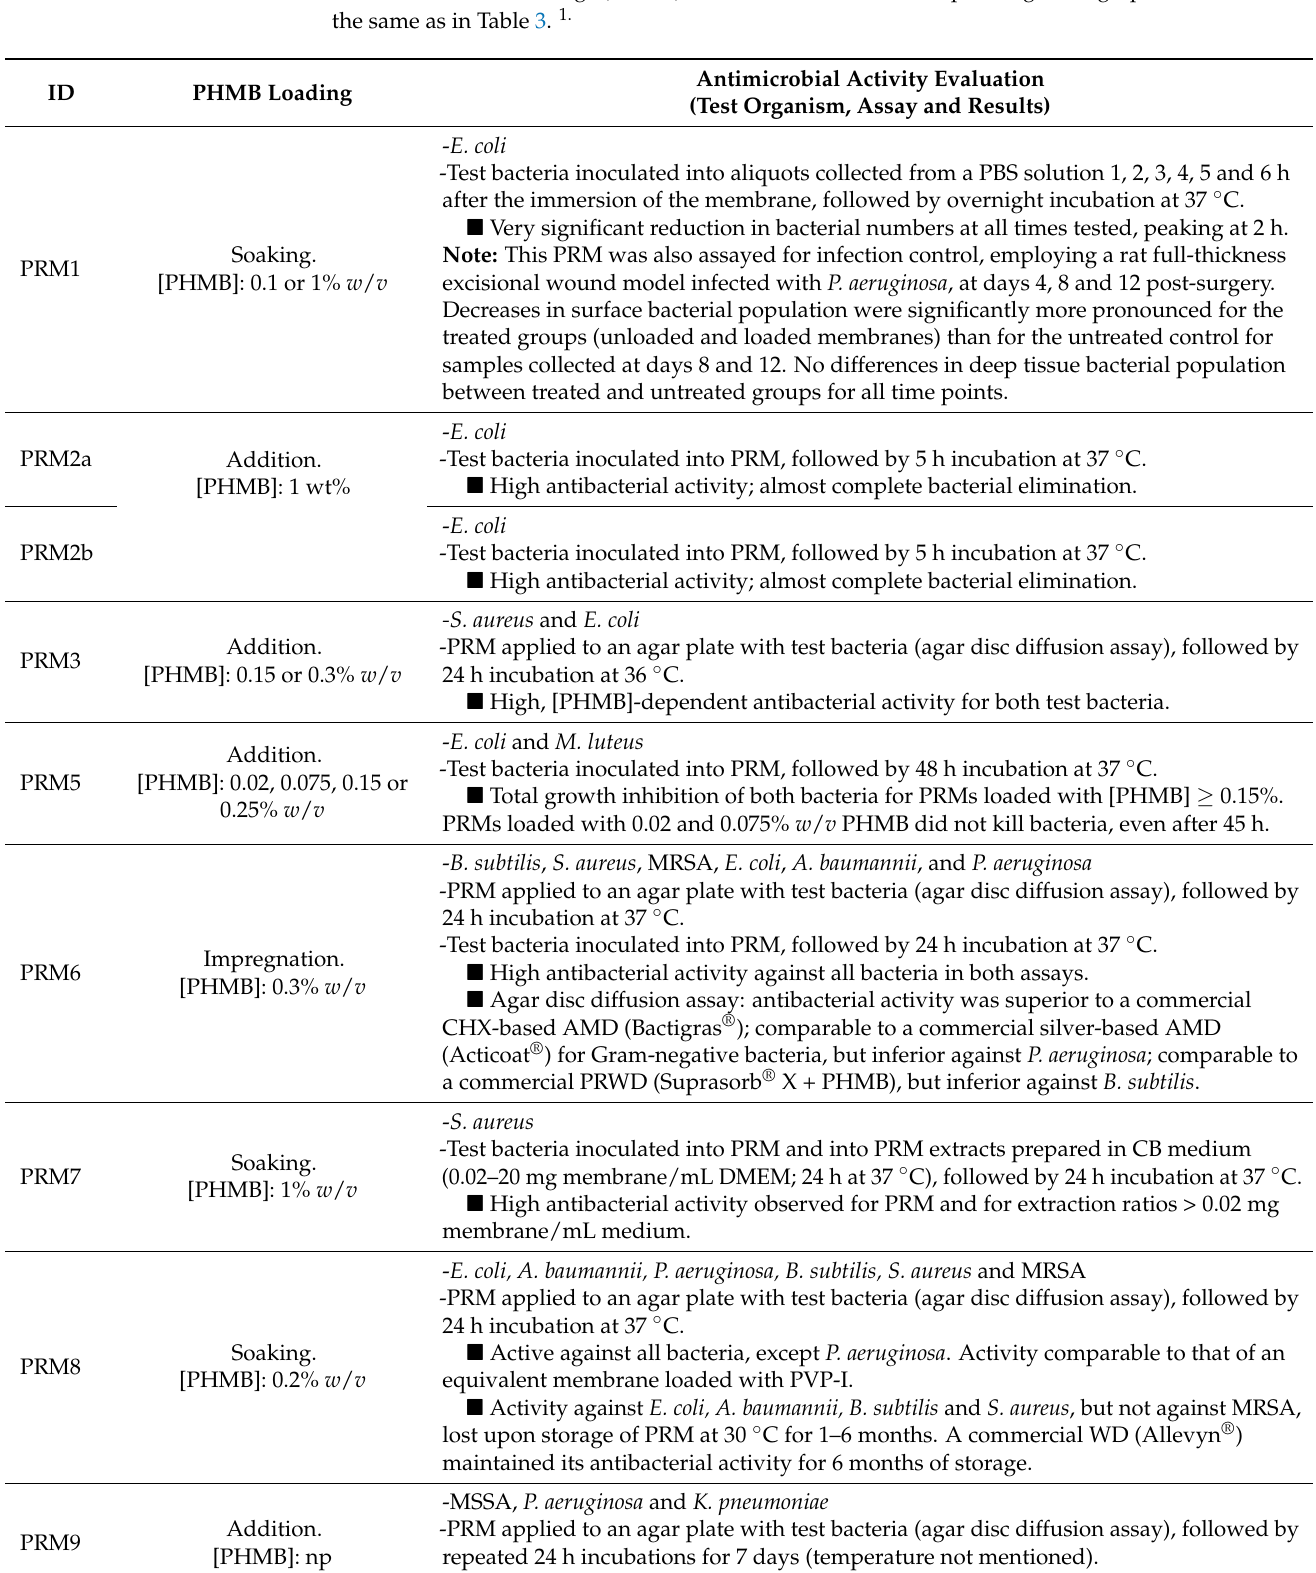
Table 8. In vitro antimicrobial activity evaluation of PHMB-releasing membranes (PRMs) developed for antimicrobial dressings (AMDs). Membrane IDs and corresponding bibliographic references are the same as in Table 3.